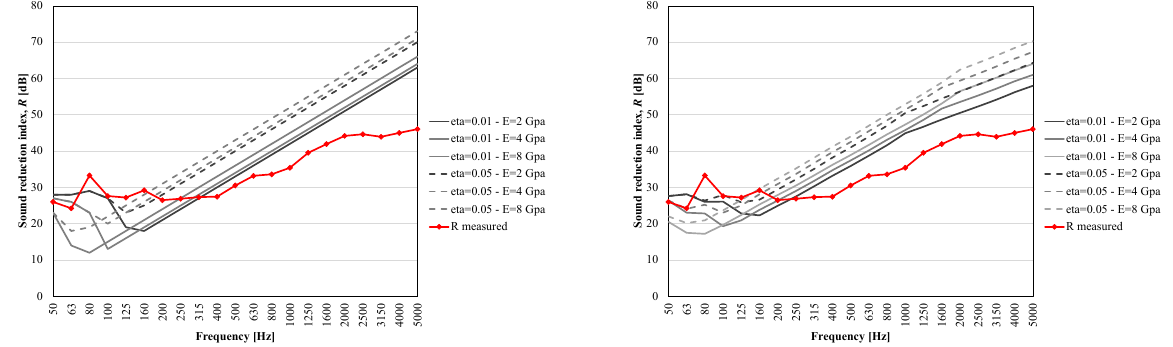
Figure 10. Measurements of sound reduction index for the 200 mm CLT floor and comparison with proposed mass law and R = 20lg( mf ) − 47.